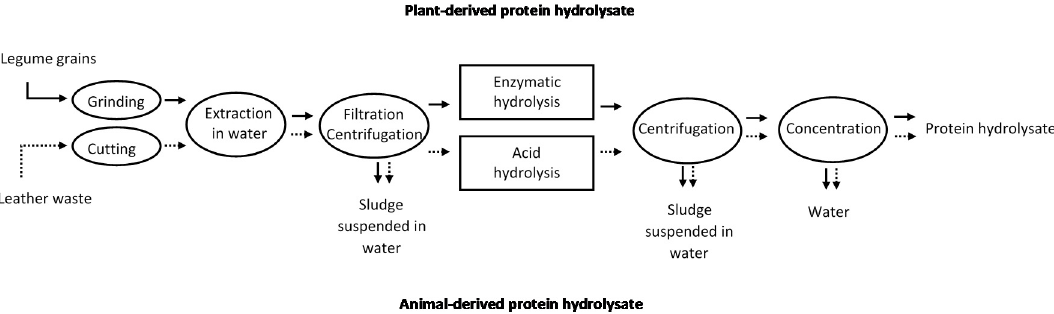
Figure 1. Production processes of protein hydrolysates: enzymatically-produced protein hydrolysate from legume grains vs. chemically-produced protein hydrolysate from leather waste. Table 1. Up-stream processes used for the LCA implementation of the two production chains of